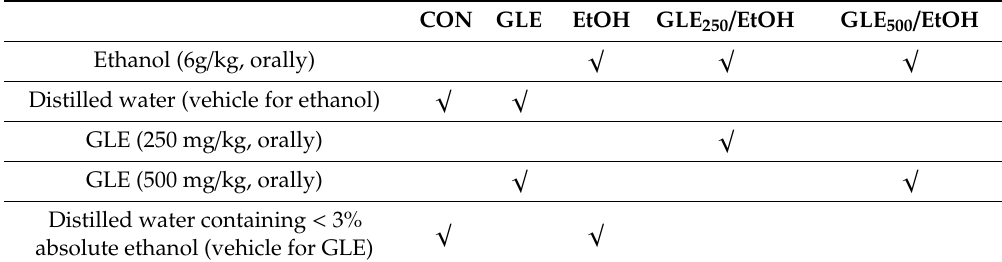
Table 1. Experiment design to determine e ff ect of grape-leaf extract (GLE) on ethanol (EtOH)-induced liver injury. CON GLE EtOH GLE 250 / EtOH GLE 500 /